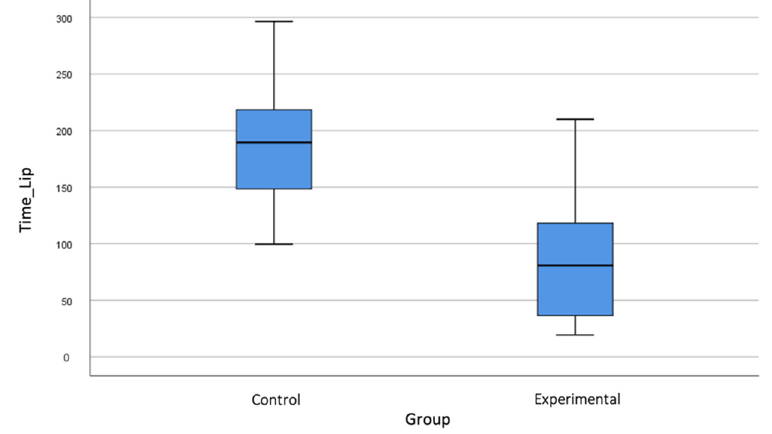
Figure 1. Bloxplot showing differences between control and experimental groups in lip numbness recovery time.